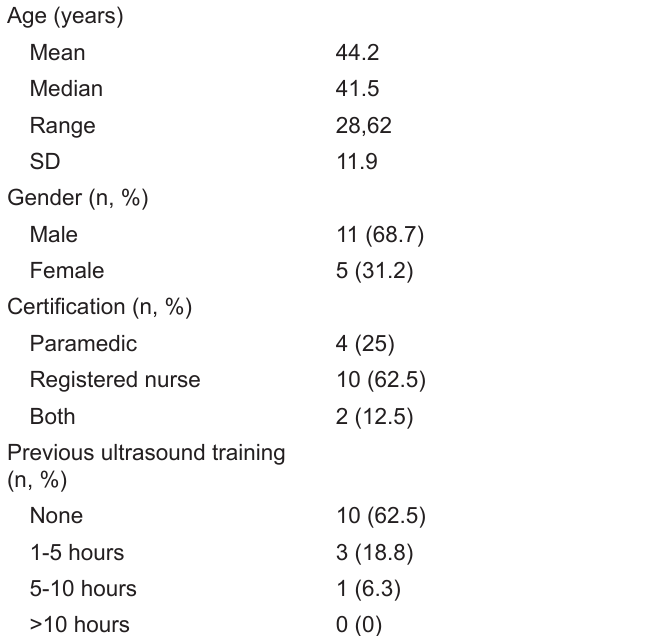
Table 2. Demographics of emergency medical services personnel who participated in ultrasound